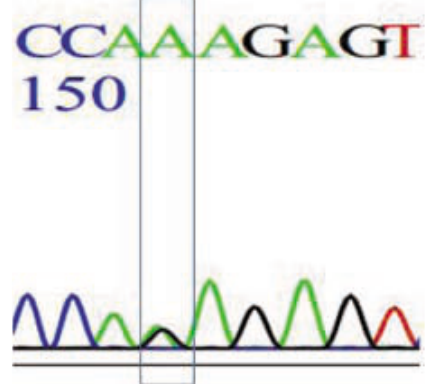
Fig. 3 . Chromatogram of AG genotype